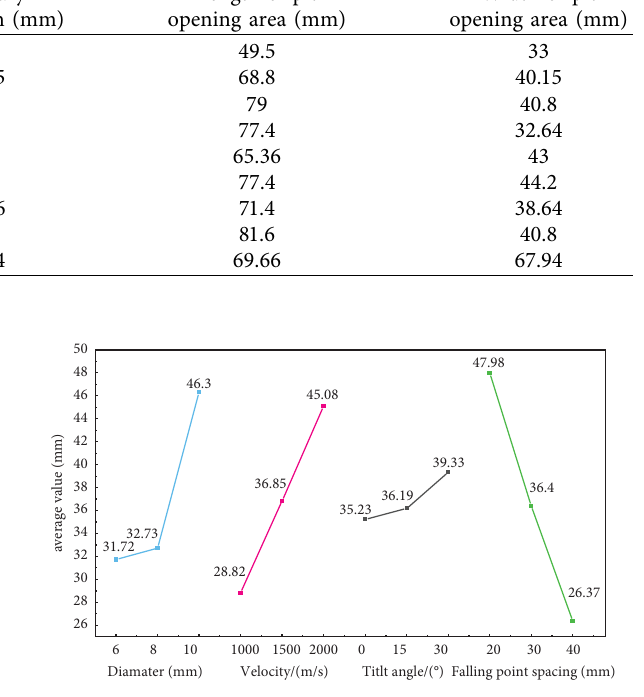
Figure 11: Infuence of various factors on the occurrence time of surface association.